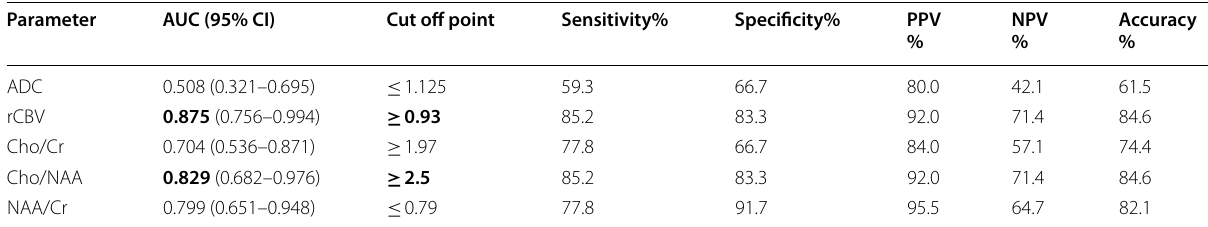
Table 2 Sensitivity, specificity, positive predictive value, negative predictive value, accuracy and confidence intervals for different MRI